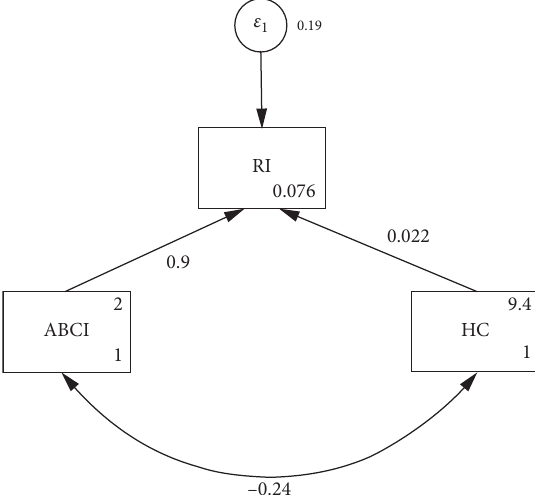
Figure 6: The magnitude of the effectiveness of ABCI and HC over RI.